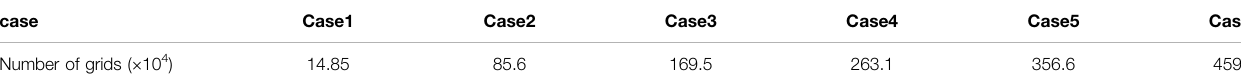
TABLE 2 | Meshing scheme.